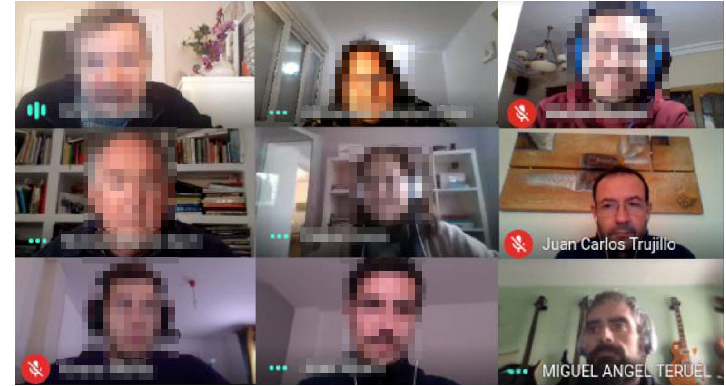
Figure 7. Participants and researchers during a remote experiment session.